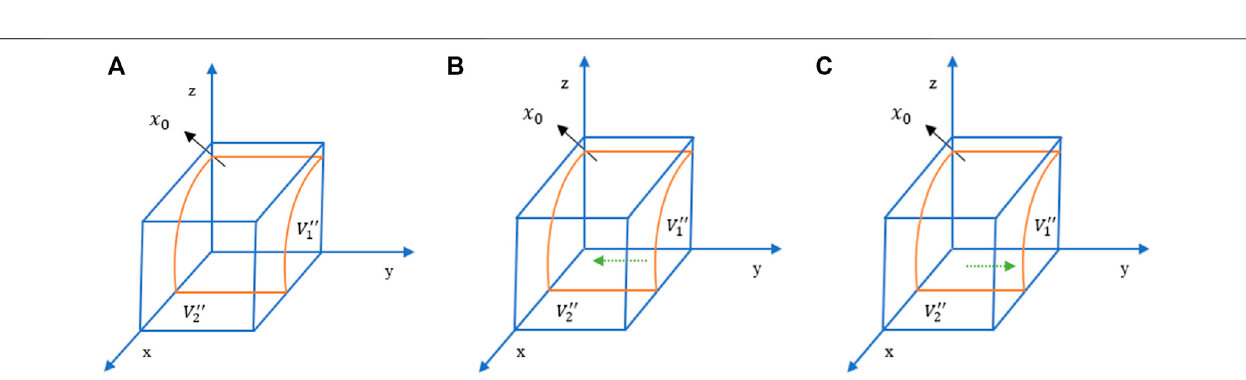
FIGURE 4 | Dynamic evolution trend of the behavior of the CP. (A) x = x 0 . (B) x < x 0 . (C) x > x 0